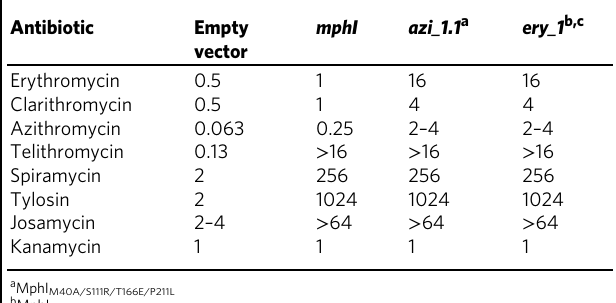
expression and resistance phenotype. Ery_1 was therefore subcloned into the wild-type pGDP4 empty vector. MICs in this table are directly (Supplementary Table 6, Supplementary Fig. 5). Using tandem mass spectrometry, we also con fi rmed that MphB phosphorylates the desosamine 2 ′ -OH of erythromycin (Supplementary Fig. 6). Moreover, MphB modi fi es macrolides with ef fi ciencies